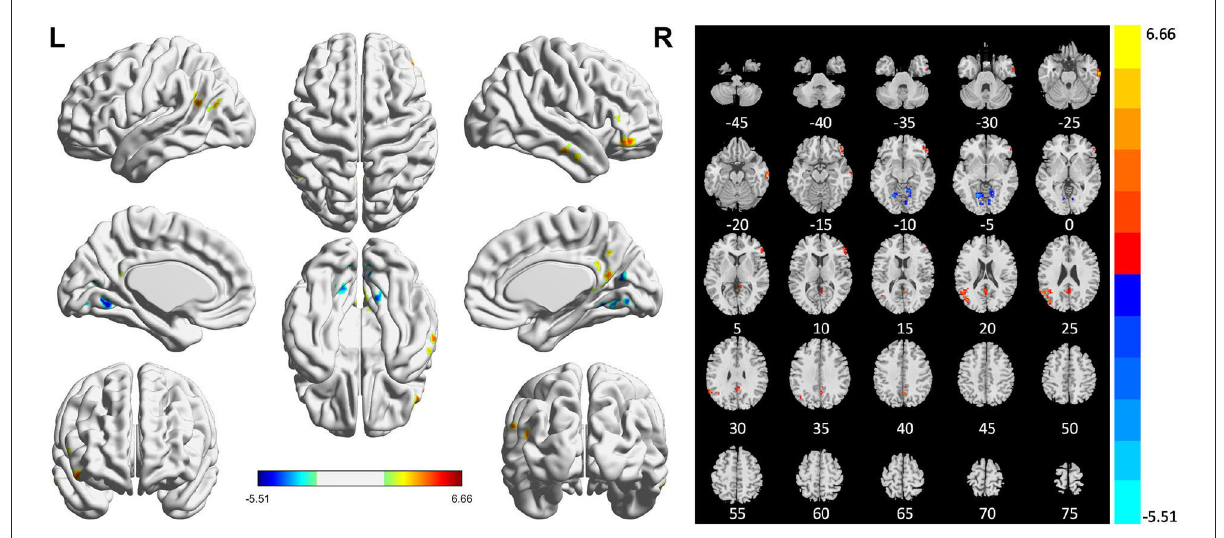
FIGURE3 Statistically significant differences between post-stroke insomnia (PSI) patients and healthy controls are shown in the amplitude of low-frequency fluctuation (ALFF) map of the whole brain with magnetic resonance imaging (MRI). Patients with PSI showed a significant ALFF increase in the bilateral middle temporal gyrus, right inferior temporal gyrus, right inferior frontal gyrus, right limbic lobe, right precuneus, left posterior cingulate gyrus, and left middle occipital gyrus (warm colors), as well as a decrease in the bilateral lingual gyrus with decreased ALFF values (cold colors). A T-score bar is shown below and right. Red and blue denote increases and decreases in ALFF, respectively.